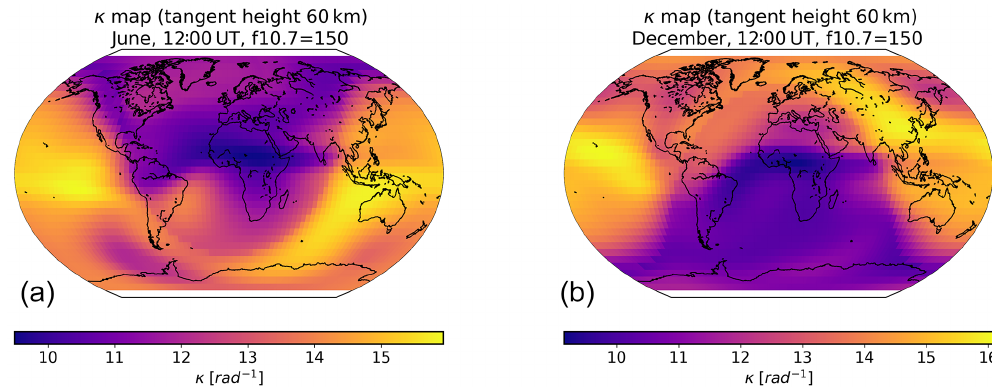
Figure 8. Estimated κ for 12:00UT, F10.7 = 150: June (a) and December (b)